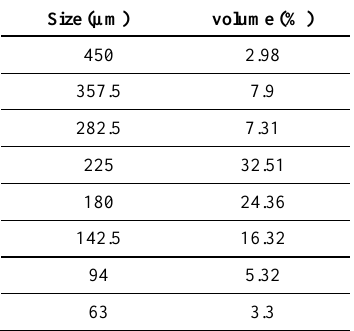
Table 2. Particle size distribution (PSD) for PE100 as HDPE grade.